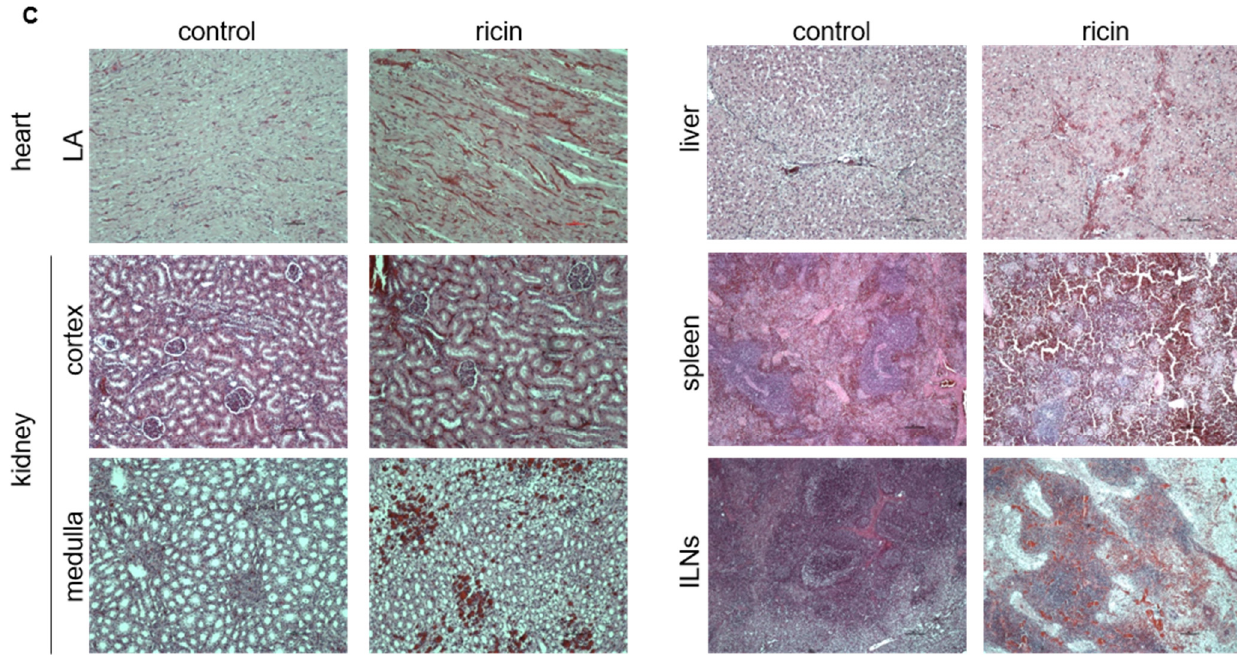
Figure 4. Coagulation parameters and histological analysis of tissues from ricin-intoxicated swine. ( A ) APTT and PT were determined in peripheral blood samples collected from control pigs (0 h) or at the indicated time points after i.m. exposure to a lethal dose of ricin (7.5 µg ricin/kg body weight); s = seconds. Each dot represents an individual pig. The results are depicted as means ± SEM. Statistical analyses were performed by one-way ANOVA followed by Dunnett’s post hoc test. *** p < 0.001; n.s., not significant. ( B ) Immunofluorescence (red) shows VWF staining on the apical side of swine arteries in control animals or 24 and 48 h after ricin exposure. Images on the right are enlargements of the apical side of the artery (as indicated by the square on the left image); the lumen of the vessel is always upwards. Nuclei stained by DAPI appear in blue. Scale bar: 20 µm (representative sections of n = 3 swine/group are shown). ( C ) Sections of the heart (left atrium, LA), cortex and medulla regions of the kidney, liver, spleen and ILNs from non-intoxicated (control) and ricin-intoxicated pigs at 24 h post-exposure. The sections were stained with hematoxylin and eosin (H&E). Scale bar: 100 µm (representative sections of n = 3 swine/group are shown).